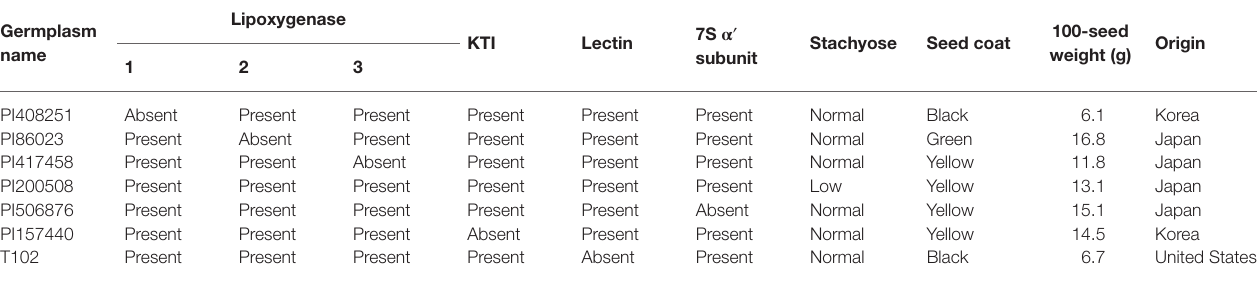
TABLE 1 | Seed coat, 100-seed weight, stachyose content, origin, presence or absence of lipoxygenase, Kunitz trypsin inhibitor (KTI), lectin and 7S α ′ subunit for seven